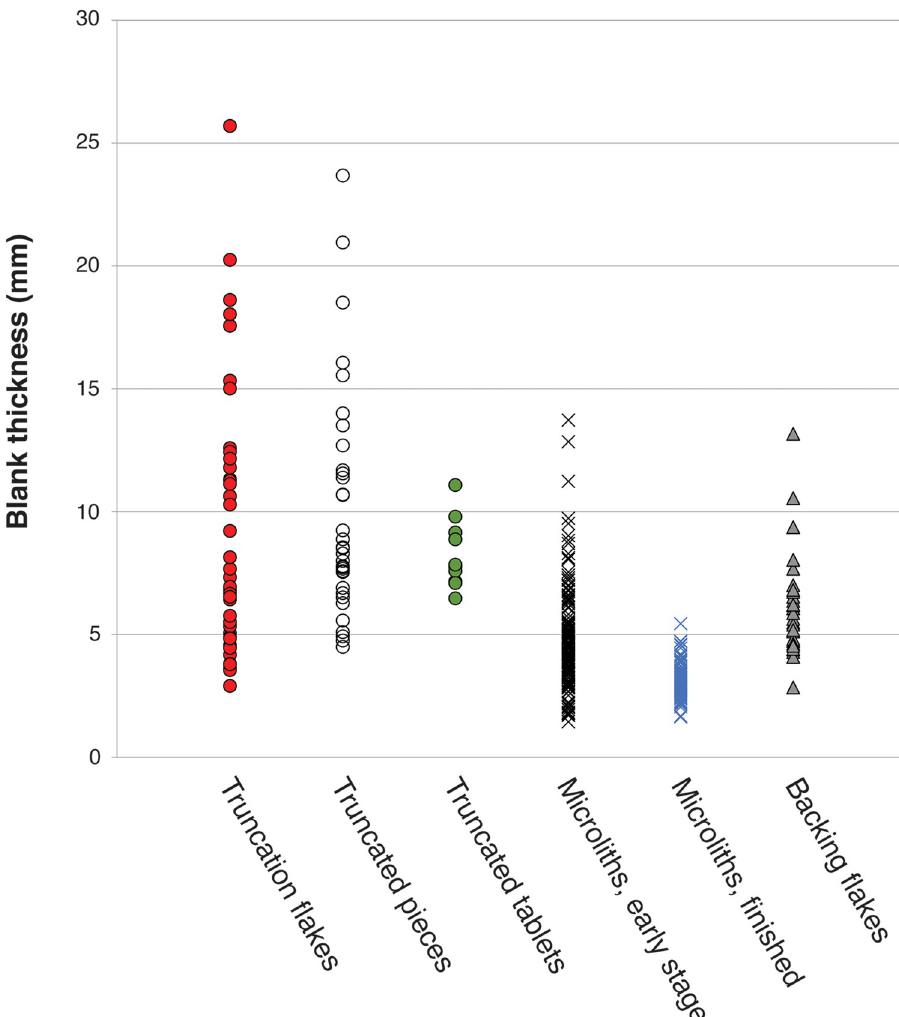
Fig 21. Thicknesses of blanks selected for truncating and backing, Horizon IV, Saruq al-Hadid. Thickness was measured directly on truncated pieces, microliths, and tile knives. Flake length is the proxy of blank thickness for truncation flakes and backing